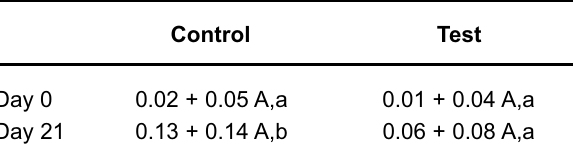
Means followed by the same uppercase letters on day 0 and day 21 do not differ statistically (p>0.05). Means followed by different lowercase letters in the same column differ statistically (p<0.01). TABLE 3- Gingival Index (GI) means and standard deviation on day 0 and day 21 for the control and test